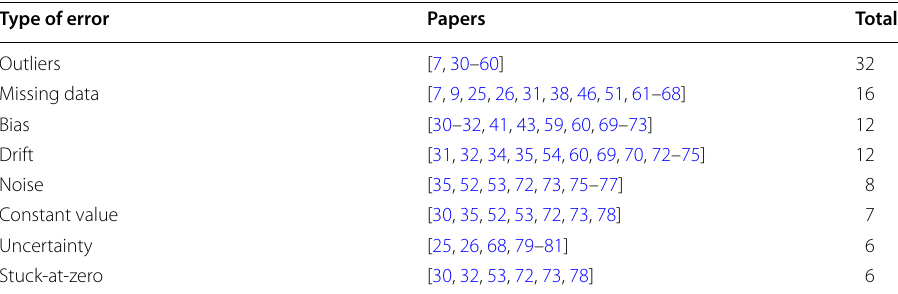
Table 2 Types of errors addressed, along with its respective papers and total number of papers that address that